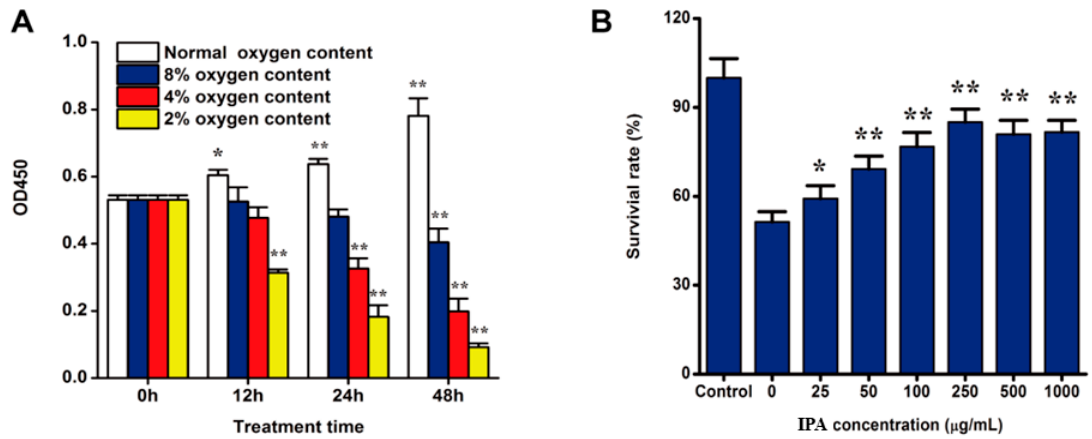
Figure 2. Hypoxia induced PC12 cell injury and IPA promote the survival of hypoxia-damaged PC12 cells. ( A ) Effect of oxygen contents and treatment time on the survival of PC12 cells; ( B ) Protective effect of IPA on hypoxia-damaged PC12 cells, as determined by CCK-8 assay. * p < 0.05, ** p < 0.01 indicates a significant difference versus the control group.